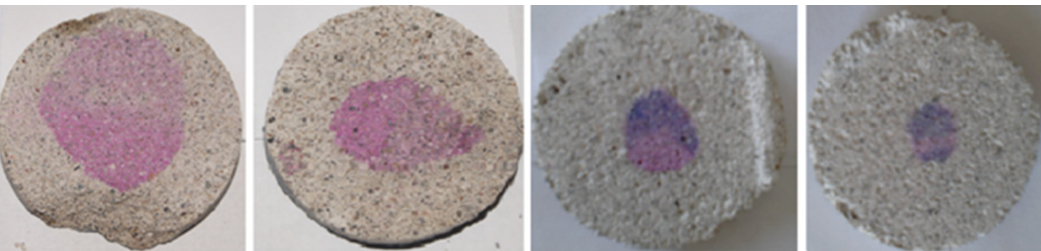
Figure 2. Vinyl paint applied in cross sections of cylinders.